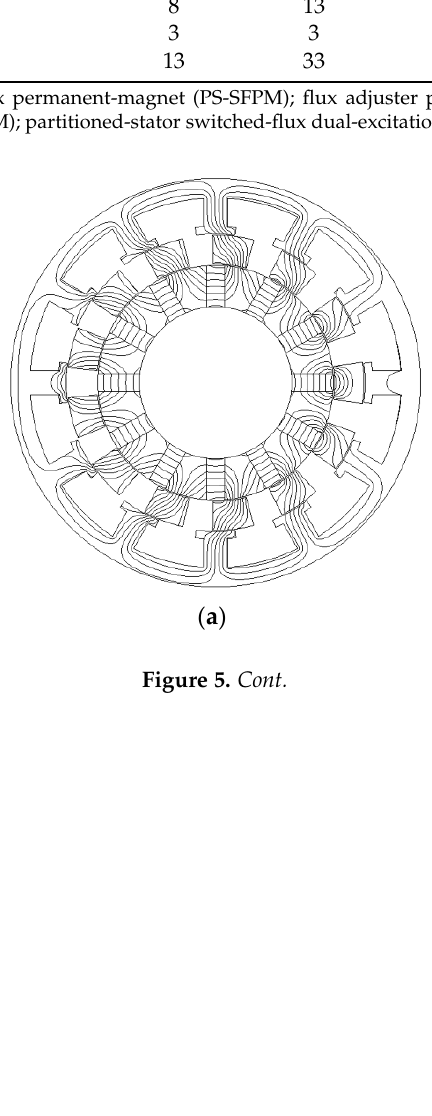
Table 1. Major Machine Parameters, machine dimensions are reproduced from [19].